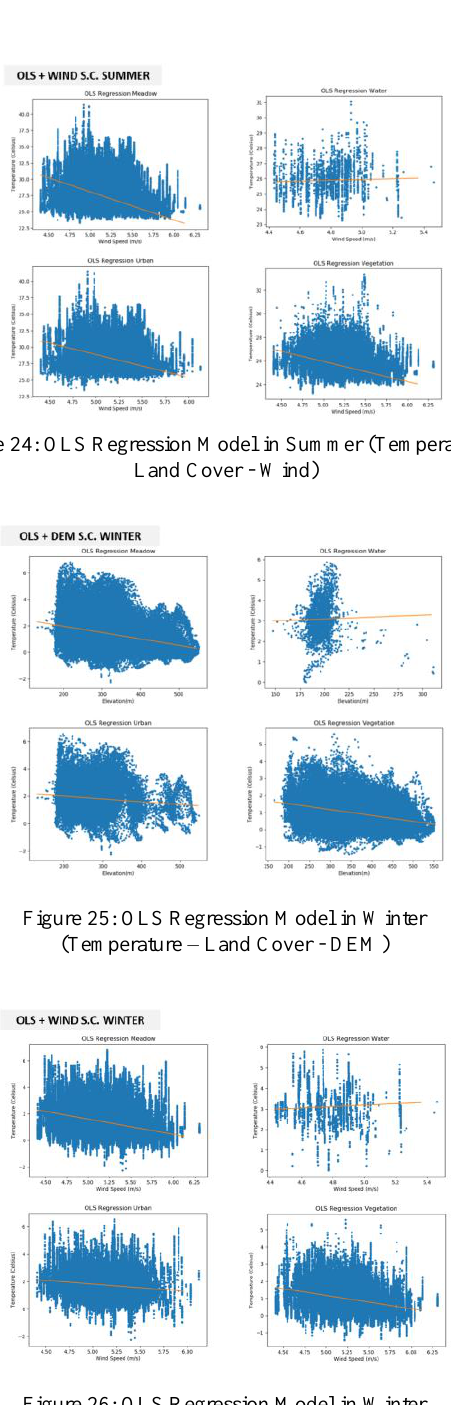
Figure 26: OLS Regression Model in